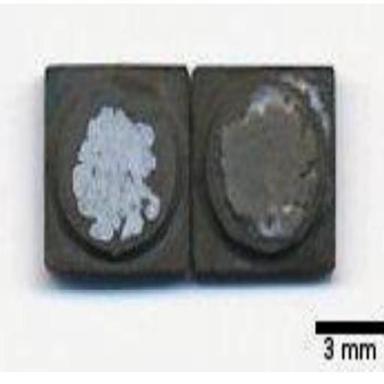
THG-5 joined sample tested at room temperature by glass-ceramic 1 (GC1): (a) polished cross-section; (b) typical fracture surfaces after torsion; (c) fracture propagation sketch (orange = glass-ceramic; grey = oxide scale; red = fracture propagation) showing the adhesive behavior, with glass-ceramic 1 (GC1) present on one fracture surface only, as observed in (d) by SEM-EDS, with each region identified (For interpretation of the references to colour in this figure legend, the reader is referred to the web v